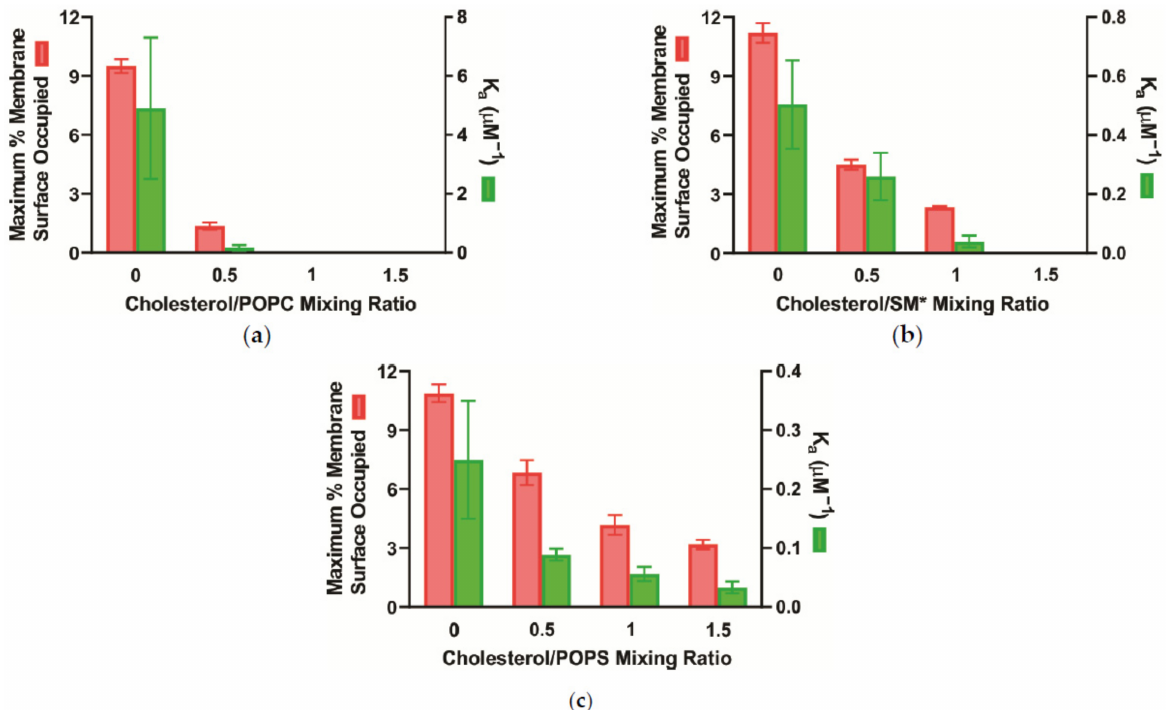
Figure 4. The maximum percentage of membrane surface occupied (MMSO) by α -crystallin and the binding affinity (K a ) of α -crystallin binding to the cholesterol/lipid (Chol/lipid) membranes at Chol/lipid mixing ratios of 0, 0.5, 1, and 1.5. ( a ) Chol/POPC membranes; ( b ) Chol/SM* membranes, where * represents the presence of 20 mol% POPS; ( c ) Chol/POPS membranes. With an increase in Chol/lipid mixing ratio for the Chol/POPC, Chol/SM*, and Chol/POPS membranes, both the MMSO by α -crystallin and K a decrease, indicating that Chol inhibits the binding of α -crystallin to these membranes. Redrawn with permission from [99,101,108], Copyright 2021, with permission from Taylor & Francis and